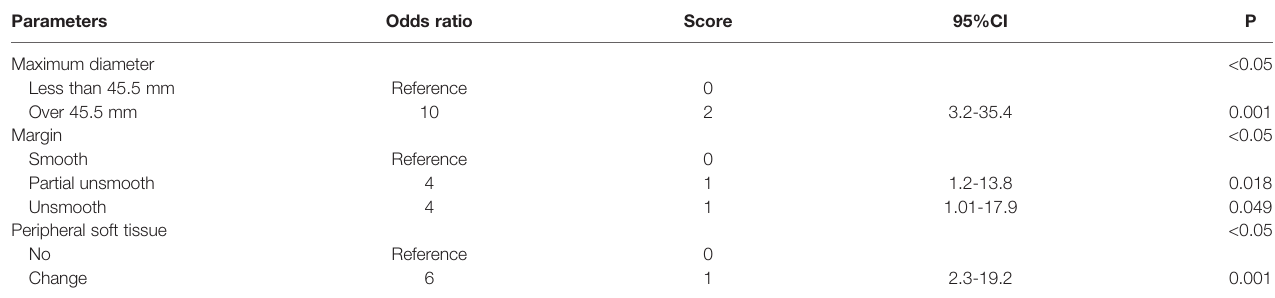
TABLE 3 | Multivariate logistic regression model with odds ratios composed of independent factors in MRI. Parameters